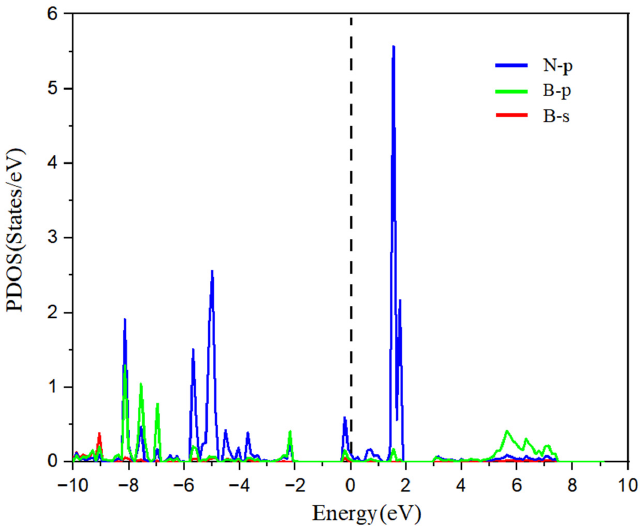
Crystals 2022 , 12 , x FOR PEER REVIEW Figure 4. Partial density of states (PDOS) of N 2 on B2@C 3 N 4 for side-on configurations. N 2 reduction on the catalyst is a six-electron related reaction, i.e., N (cid:2870) + 6H (cid:2878) + 6e (cid:2879) → 2NH (cid:2871) . Generally, the reaction may involve three possible reaction mechanisms,